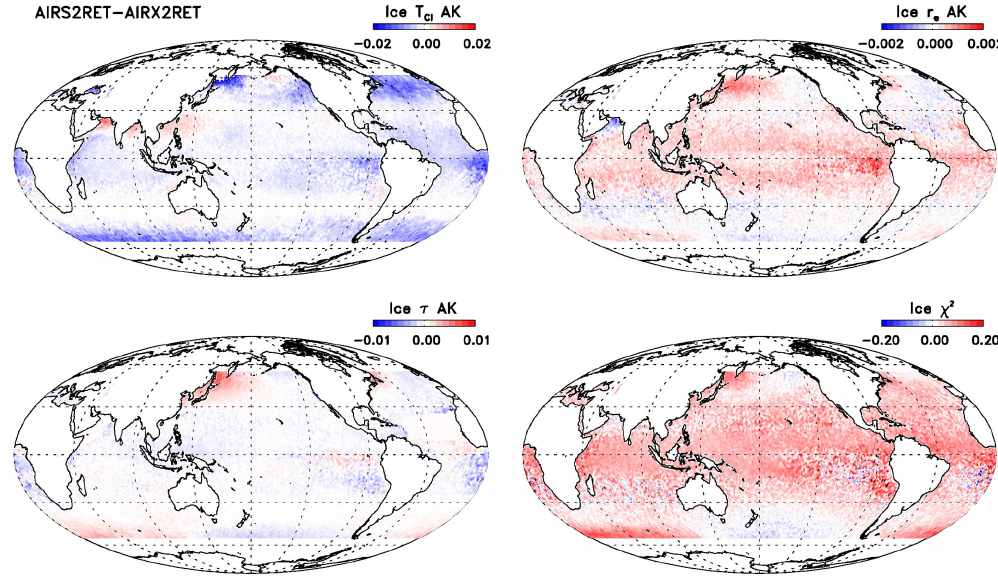
Figure A2. Same as Fig. A1, except for the T ci , r ei , and τ i AKs, and the χ 2 fitting parameter. Note that the minimum and maximum differences may exceed those indicated in the colour